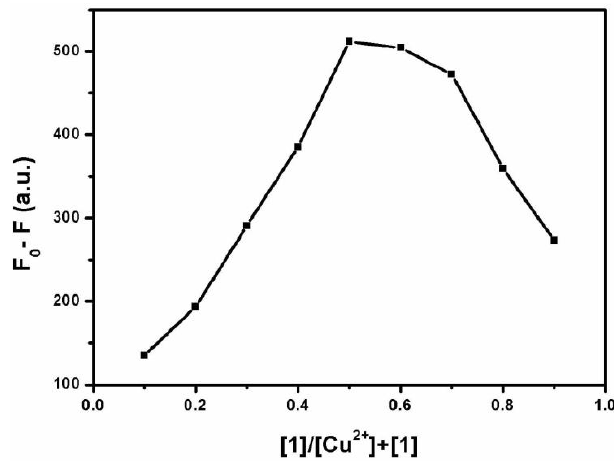
Figure 2. Job plot of the binding between Probe 1 and Cu 2+ in ethanol, with the total concentration of the two kept constant at 10 μM. F 0 and F are fluorescence intensities measured at 387 nm in the absence and presence of Cu 2+ , respectively.